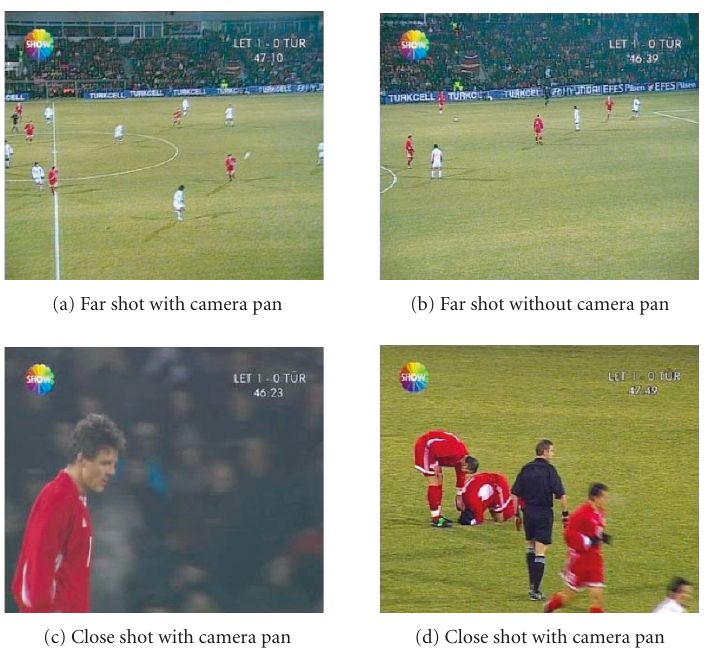
Figure 5: Four shot types with respect to distance of shots and type of